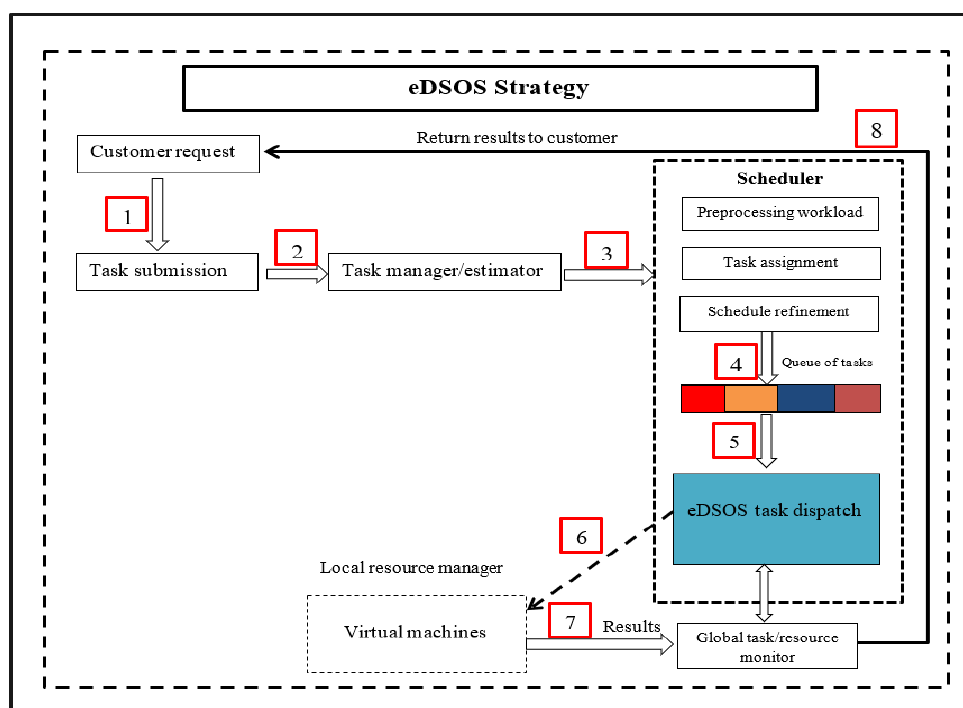
Figure 2. The proposed model of the eDSOS task scheduling strategy.